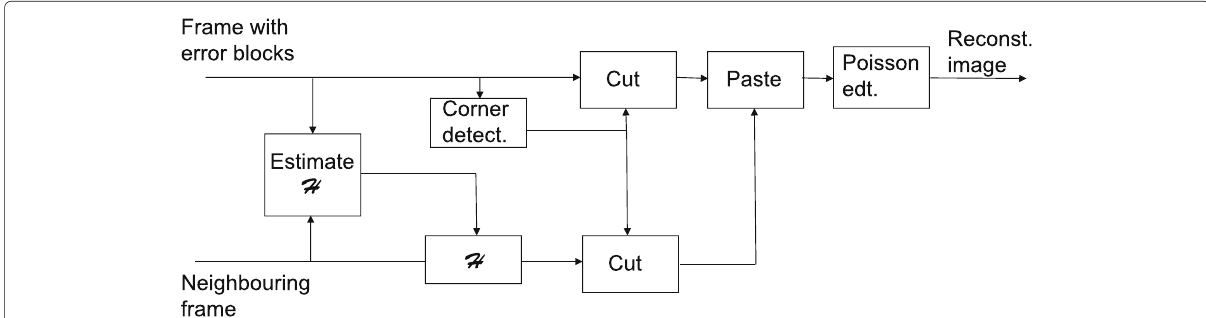
Fig. 5 Block diagram for suggested temporal inpainting scheme for error